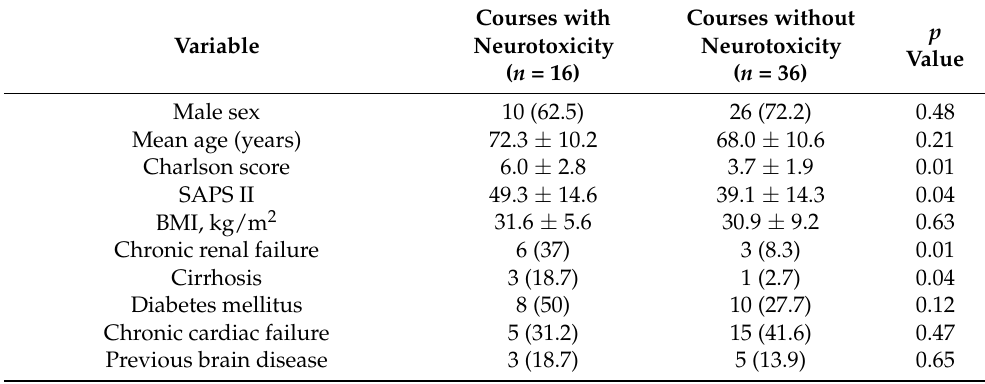
Table 4. Univariate analysis defining clinical and biological characteristics associated with neurotoxi- city in 52 courses of cefepime treatment.